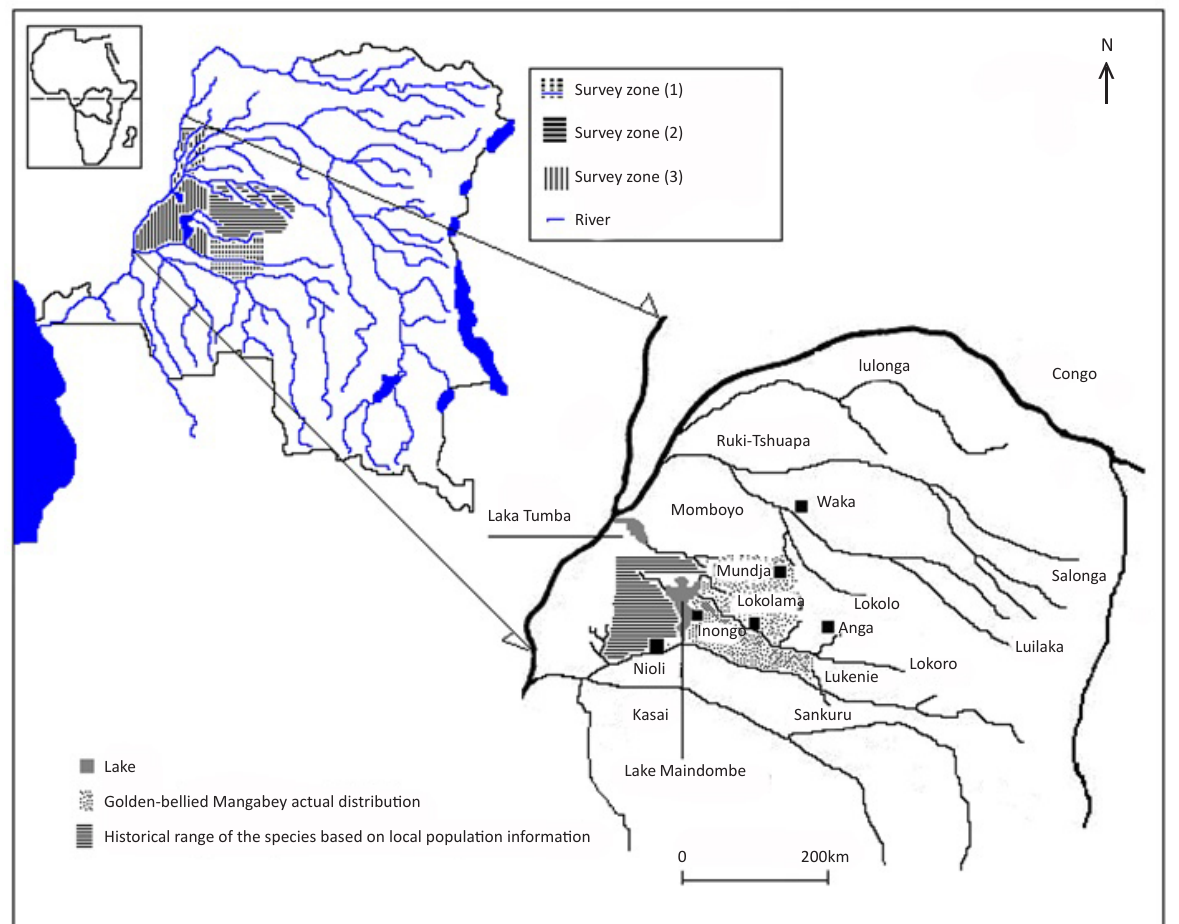
Figure 1. Survey zones and plotted distribution of Cercocebus chrysogaster